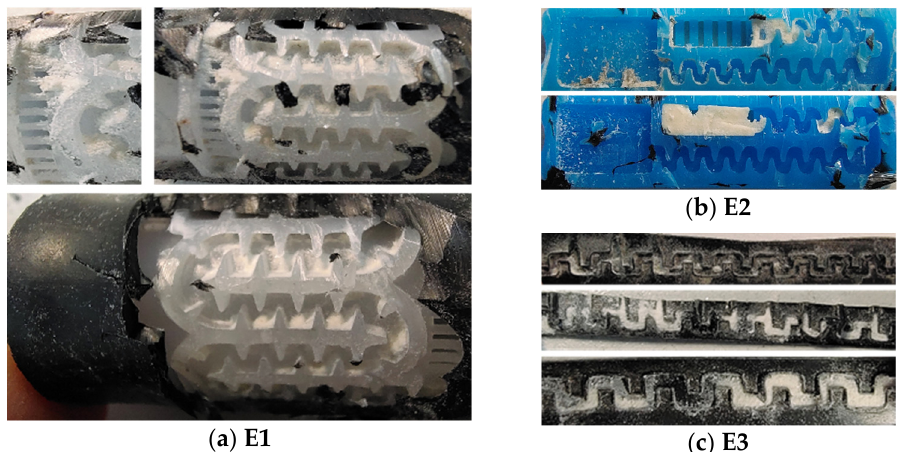
Figure 5. Clogging distribution of emitters. ( a )The clogging distribution E1. ( b )The clogging distribution E2. ( c )The clogging distribution E3.